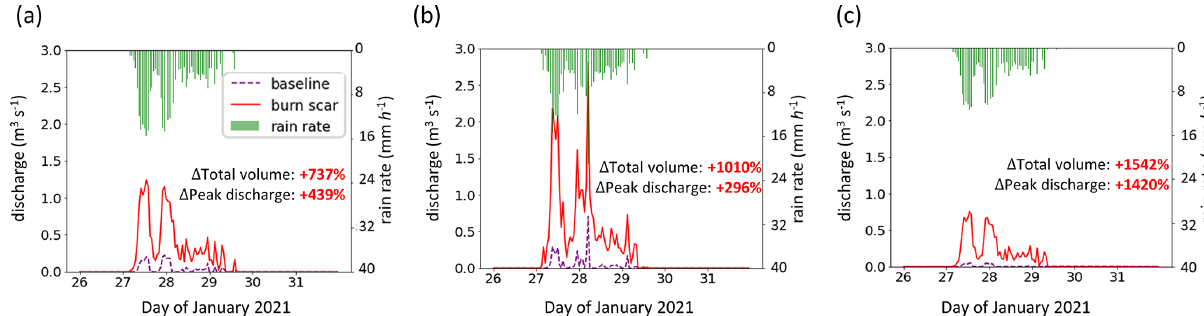
Figure B5. WRF-Hydro-simulated discharge time series at four debris flow source areas. (a–c) MRMS precipitation (mmh − 1 ; green bars) and simulated discharge time series for 26 January 00:00 to 31 January 23:00 at Mill Creek, Big Creek, and Nacimiento debris flow source areas (black circles in Fig. 7b–d) in baseline (m 3 s − 1 ; dashed purple line) and burn scar simulation (m 3 s − 1 ; red